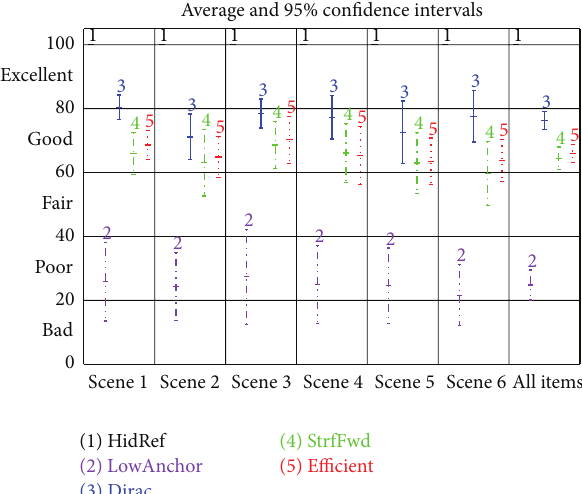
Figure 18: Results of a MUSHRA listening test comparing DirAC (Dirac) against a sequence of directional filtering, SAOC (StrfFwd) and efficient DirAC-to-SAOC transcoding (Efficient). A M/S stereo signal served as a reference (HidRef), while a monodownmix represented the lower anchor